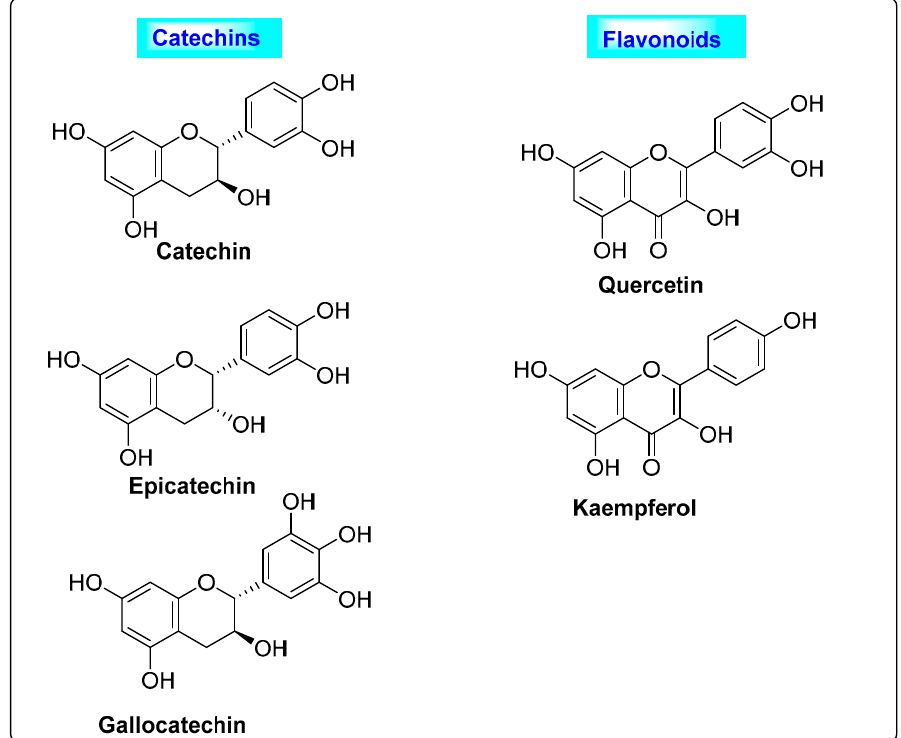
Figure 10. Phenolics present in Punica granatum having anti-androgen